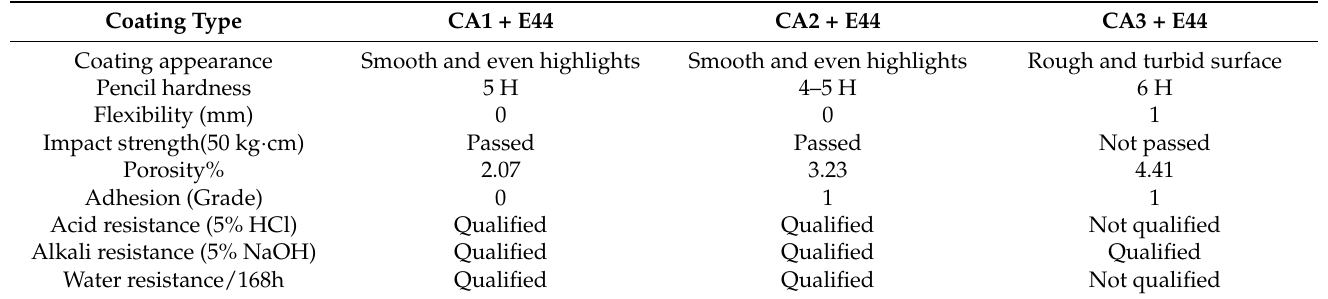
Figure 11. Nyquist curves of different coatings in 3.5 wt% NaCl ( a ) and 3.5 wt% KOH ( b ).